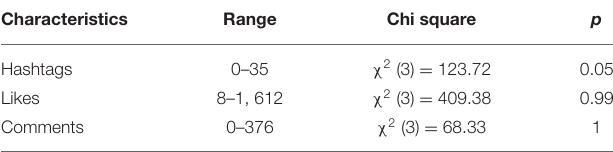
TABLE 4 | Correlation of post engagement with sentiment. Characteristics